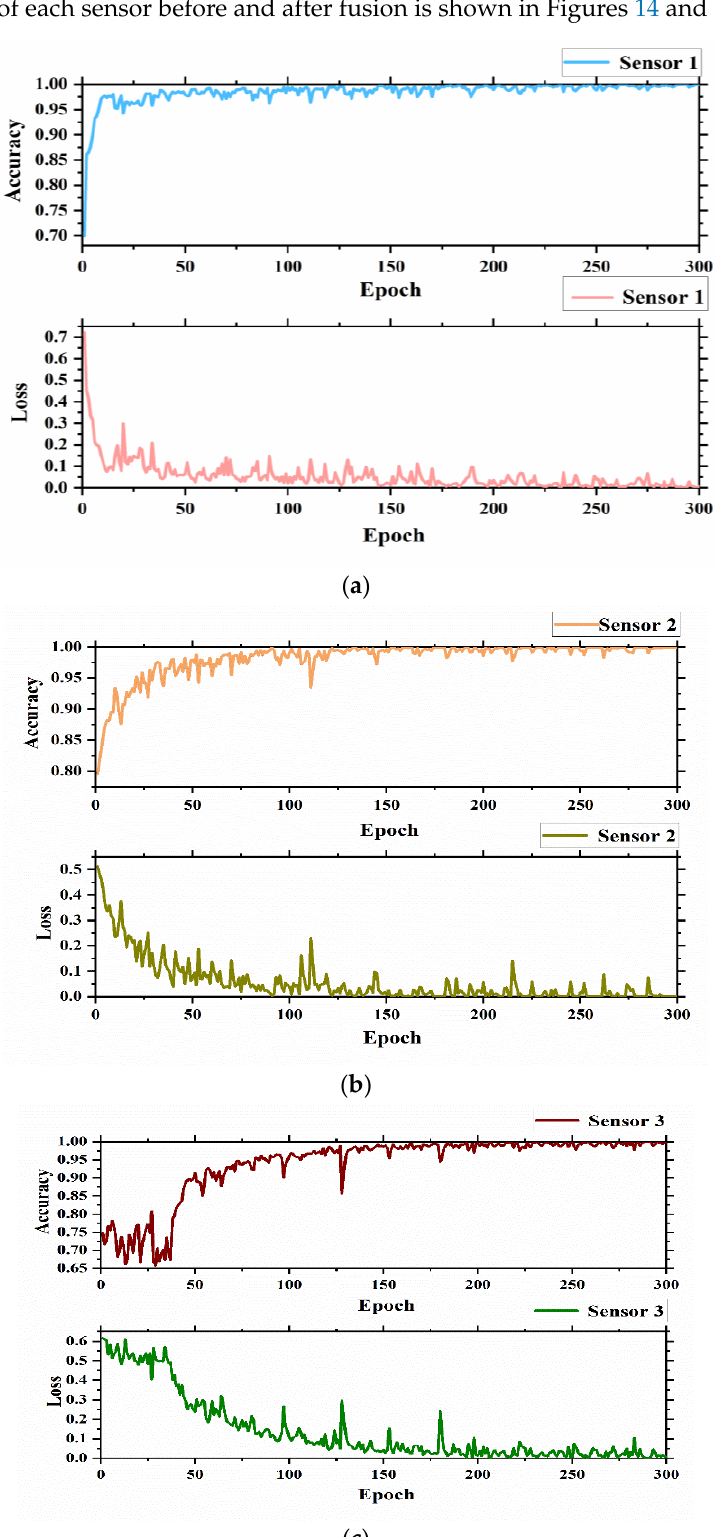
Figure 13. VGG16 experimental results. ( a ) Sensor 1 experimental results. ( b ) Sensor 2 experimental results. ( c ) Sensor 3 experimental results.